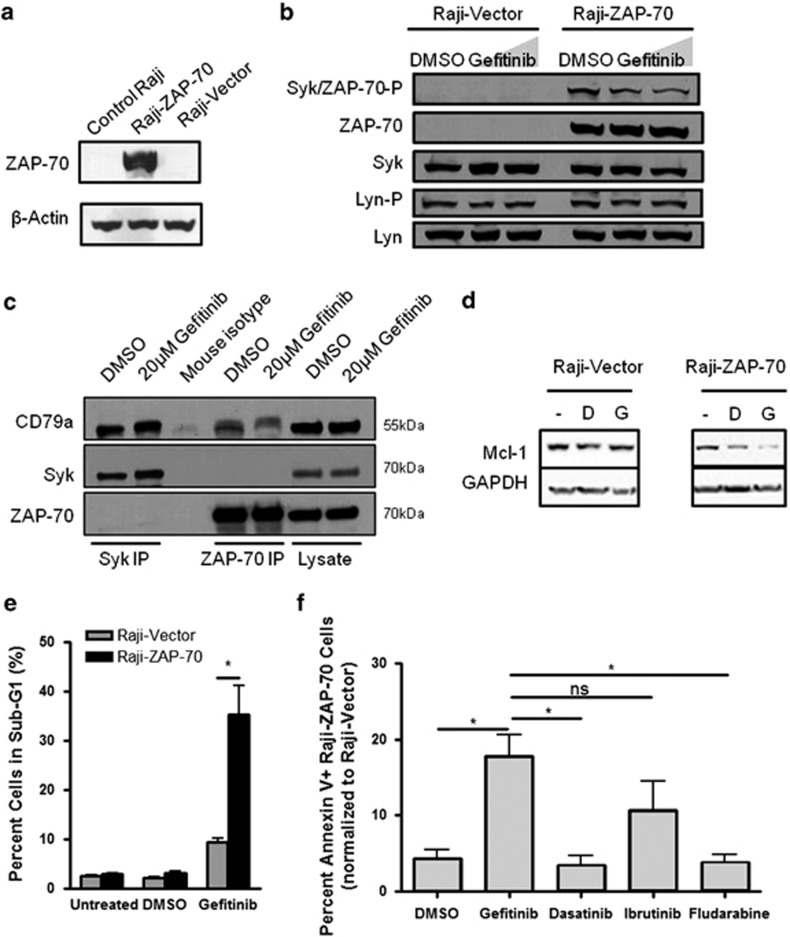
ZAP-70 expression sensitizes Raji cells to gefitinib treatment. Raji cells transduced with GFP control vector or ZAP-70 vector (a) were treated with DMSO, and 20 or 30 μM gefitinib, or left untreated for 1 h and analyzed for Syk/ZAP-70 phosphorylation by western blot (b). (c) Co-immunoprecipitation of Syk or ZAP-70 with CD79a in Raji-ZAP-70 cells treated with DMSO or 20 μM gefitinib for 24 h and then lysed in 0.2% CHAPS buffer. (d) Lysates of untreated (-) and treated with DMSO (D) or gefitinib (G) Raji-ZAP-70 and Vector cells were analyzed by western blot for Mcl-1 degradation. (e) Raji-vector and Raji-ZAP-70 cells were treated with 20 μM gefitinib and stained with propidium iodide and analyzed by flow cytometry. Results from three independent experiments are shown (unpaired t-test). (f) Raji-vector and Raji-ZAP-70 cells were treated with DMSO, 20 μM gefitinib, 30 μM dasatinib, 20 μM ibrutinib, or 20 μM fludarabine for 24 h and then stained with Annexin V-APC and 7-AAD and analyzed by flow cytometry. Cell death of Raji-ZAP-70 cells normalized to Raji-vector cells. Results from three independent experiments are shown. *P<0.05